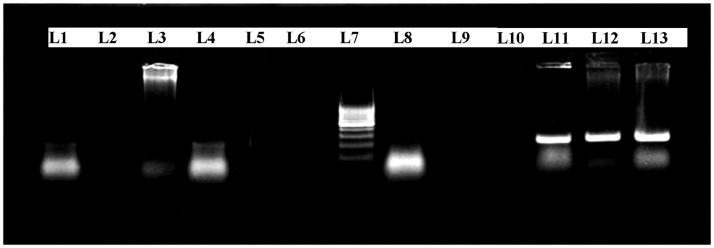
Effect of lysate therapy on Brucella specific RNA in Brucellosis affected cattle.RTPCR of plasma RNA from lysate treated / untreated diseased cattle at 75th and 90th day. L1 = S19 lysate immunized animal no. 1 on 75th day post immunization; L2 = S19 lysate immunized animal no. 1 on 90th day post immunization; L3 = S19 lysate immunized animal no. 2 on 90th day post immunization; L4 = RB51 lysate immunized animal no. 1 on 75th day post immunization; L5 = RB51 lysate immunized animal no. 1 on 90th day post immunization; L6 = RB51 lysate immunized animal no. 2 on 90th day post immunization; L7 = Molecular marker; L8 = Cocktail (S19 lysate + RB51) lysate immunized animal no. 1 on 90th day; L9 = Cocktail (S19 lysate + RB51) lysate immunized animal no. 2 on 90th day; L10 = Cocktail (S19 lysate + RB51) lysate immunized animal no. 3 on 90th day; L11 = S19 lysate immunized animal no. 1 on zero day; L12 = RB51 lysate immunized animal no. 1 on zero day; L13 = Cocktail (S19 lysate + RB51 lysate) immunized animal no. 1 on zero day.